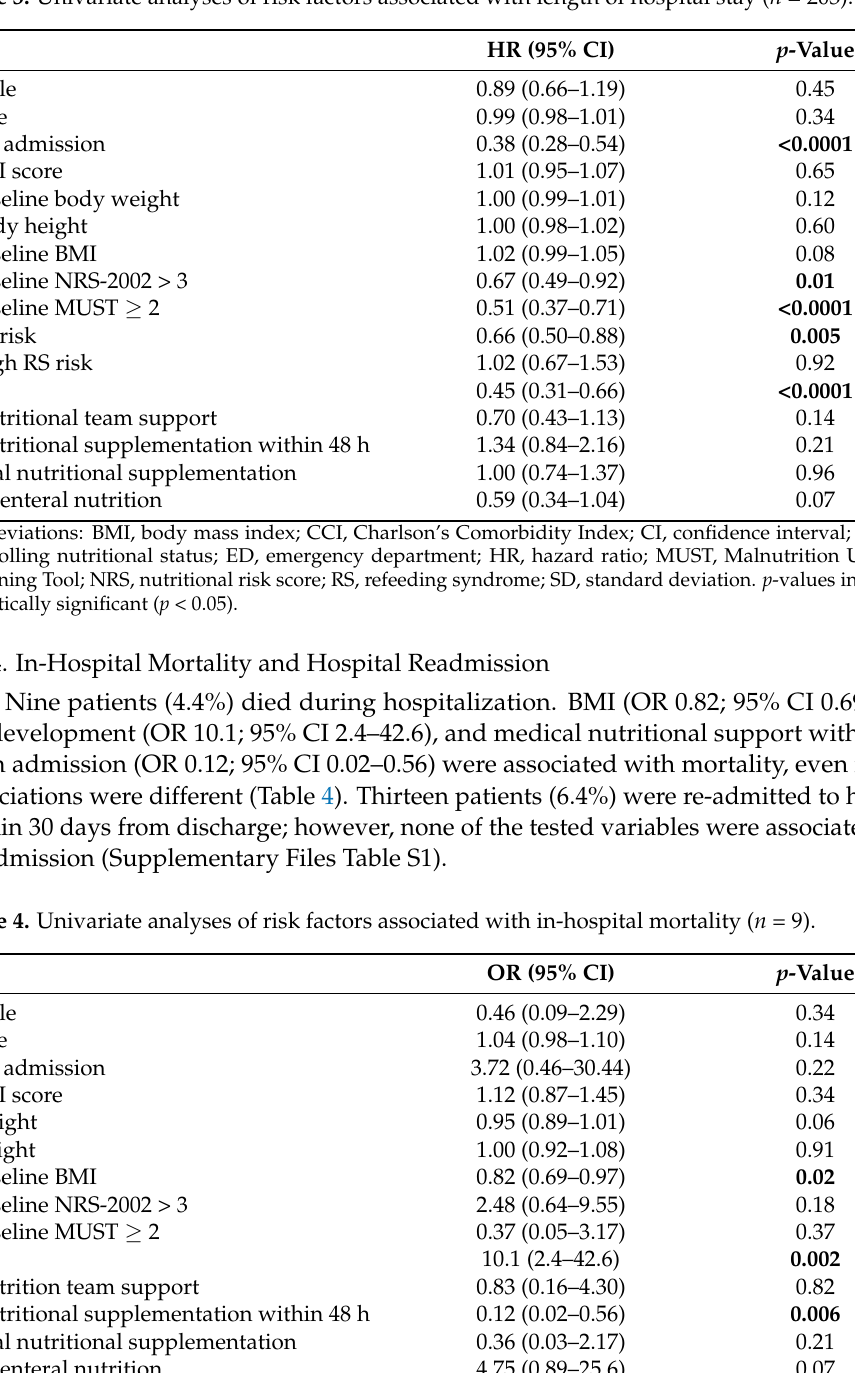
Table 3. Univariate analyses of risk factors associated with length of hospital stay ( n = 203).